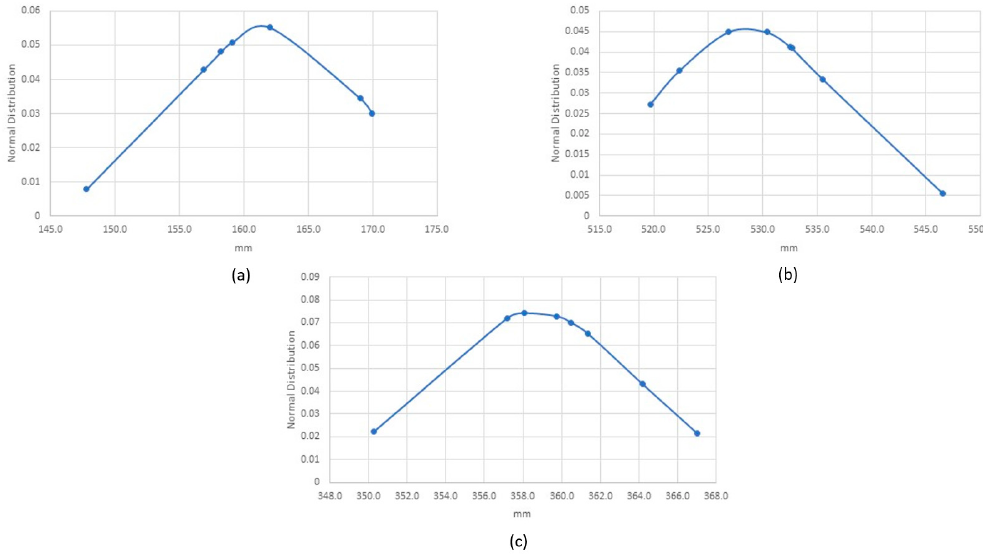
Figure 7. Case 1 -Exclusive series of exercises per joint ( a ) on the x -axis, ( b ) on the y -axis, and ( c ) on the z -axis.